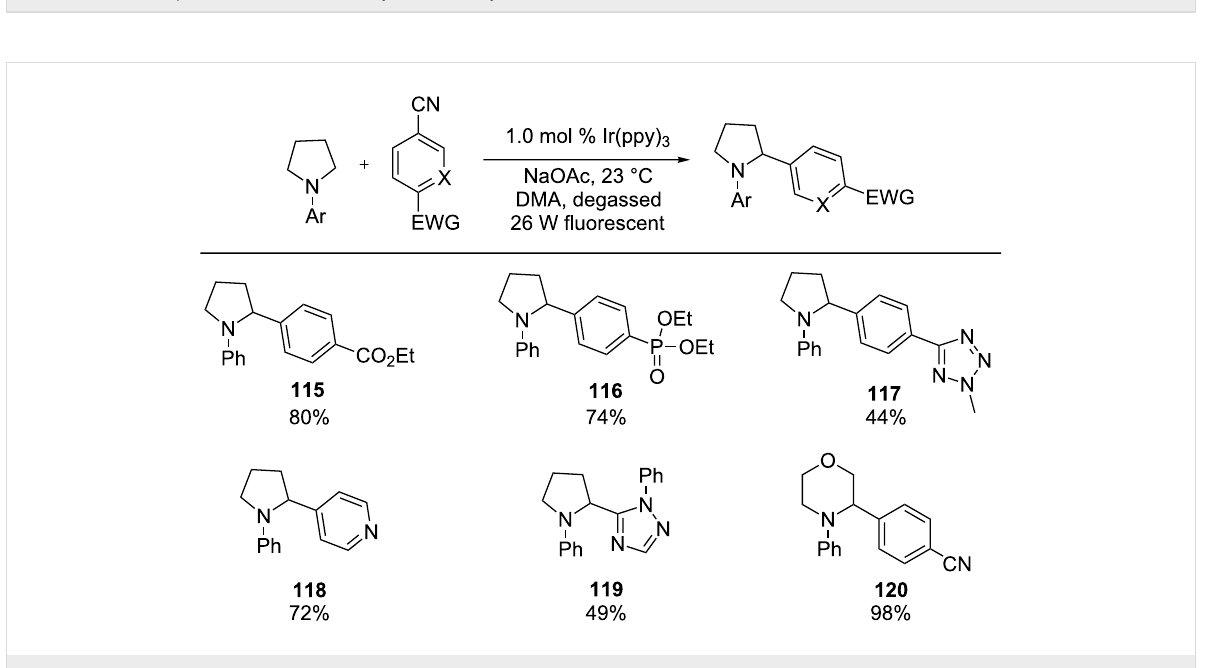
Scheme 27: α -Arylation of